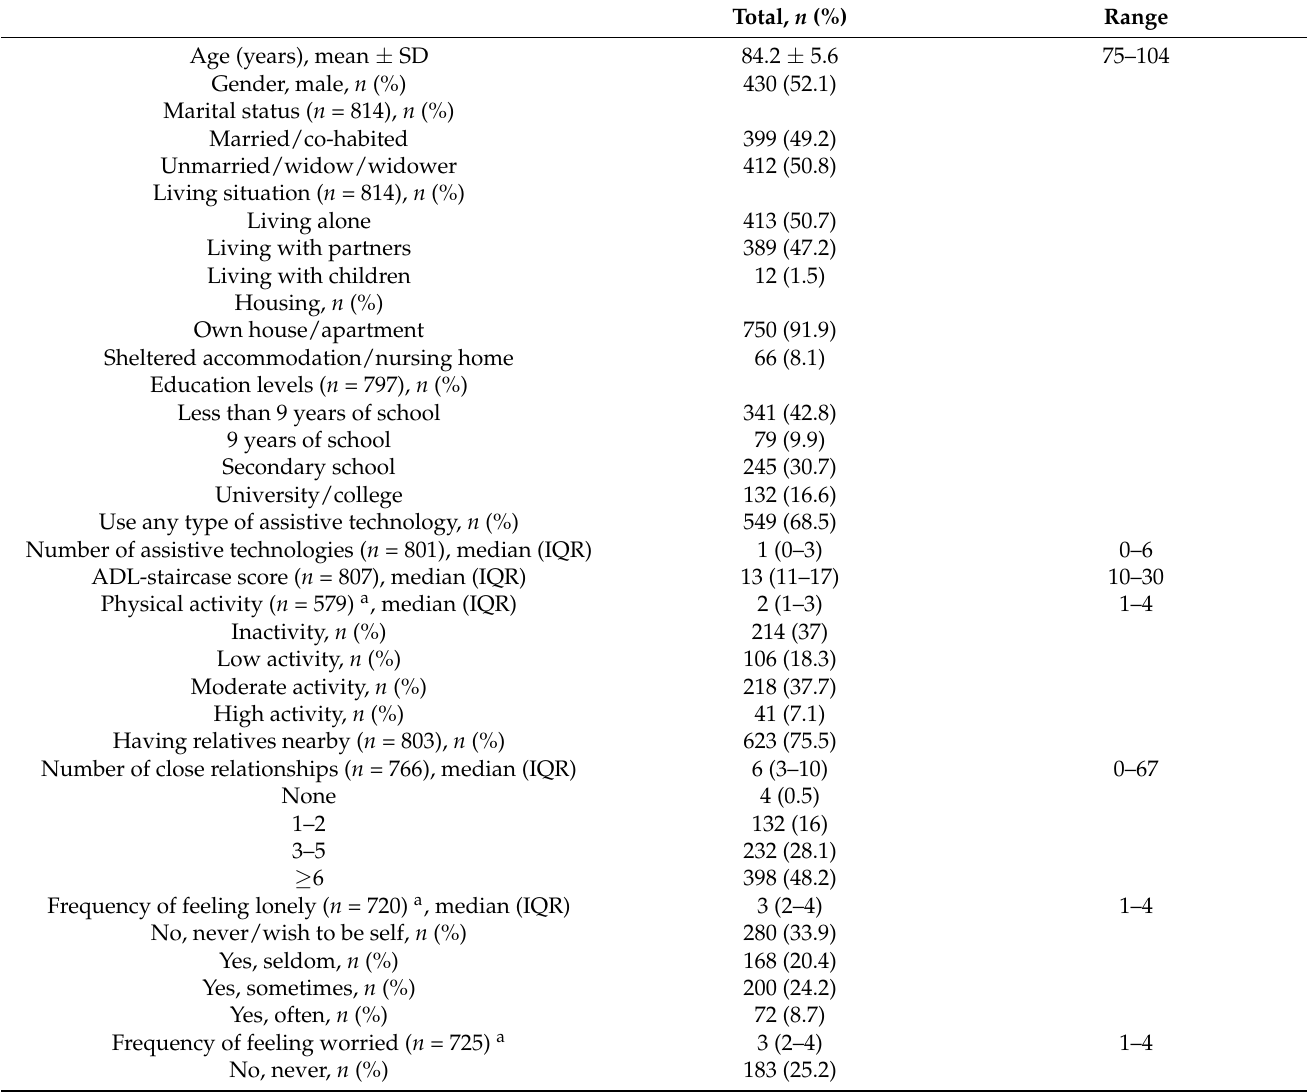
Table 1. Sociodemographics, physical functions, social network, and quality of life.